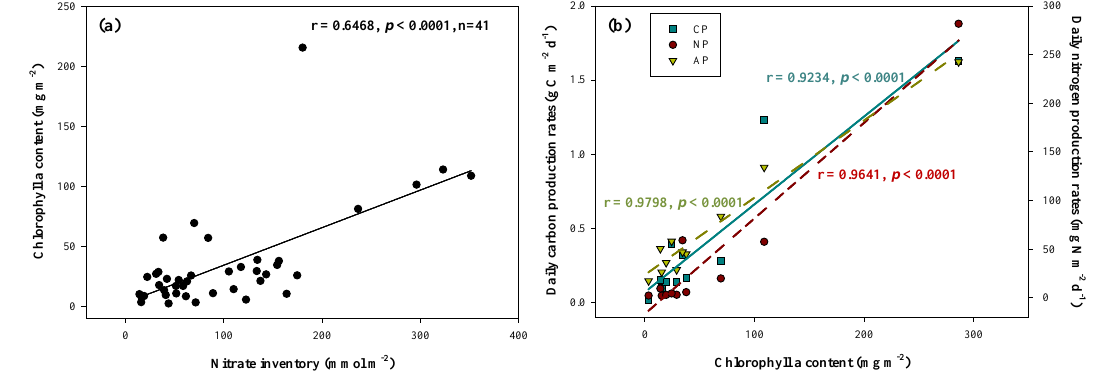
Figure 8. Relationships between (a) nitrate inventory (mmolm − 2 ) and chlorophyll a content (mgm − 2 ) in the upper 30m ( n = 41) and (b) chlorophyll a content (mgm − 2 ) and daily carbon (gCm − 2 d − 1 ) and nitrogen production rate (mgNm − 2 d − 1 ) over the euphotic zones ( n = 11). All data obtained during the 2012 RUSALCA